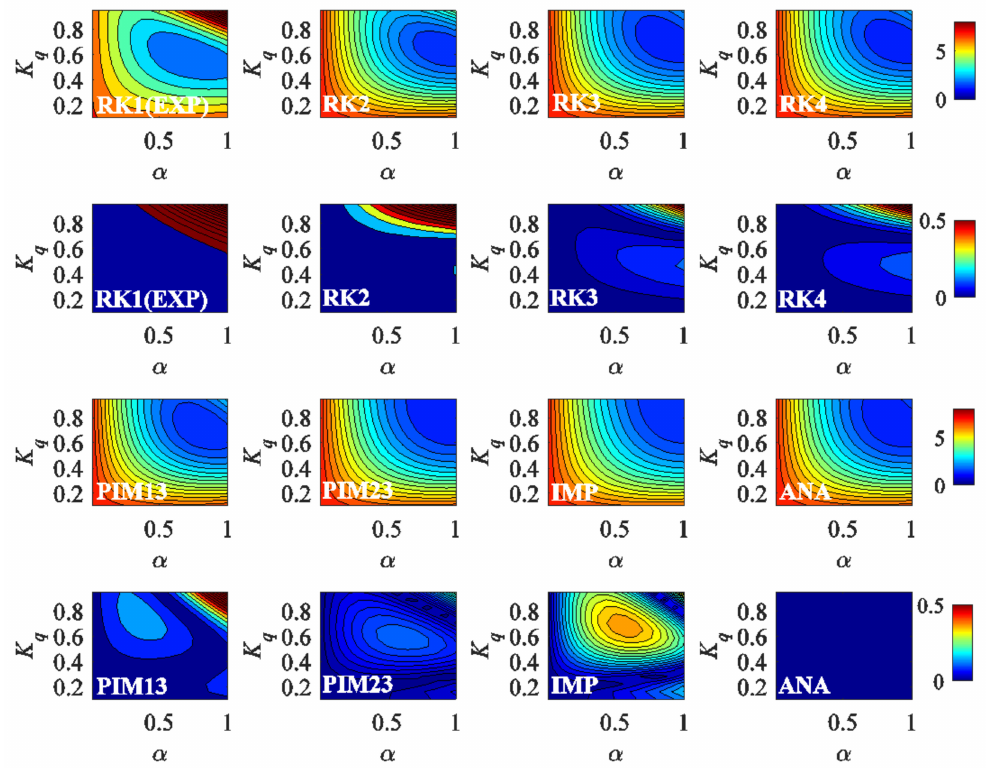
Figure 6. Two-dimensional sensitivity analysis (2DSA) with different numerical schemes for α and K q . First row: mean square error (MSE) response surfaces for RK1 to RK4; second row: MSE difference between the analytical and numerical solutions for RK1 to RK4; third row: MSE response surfaces for the Euler schemes; fourth row: MSE difference between the analytical and numerical solutions for the Euler